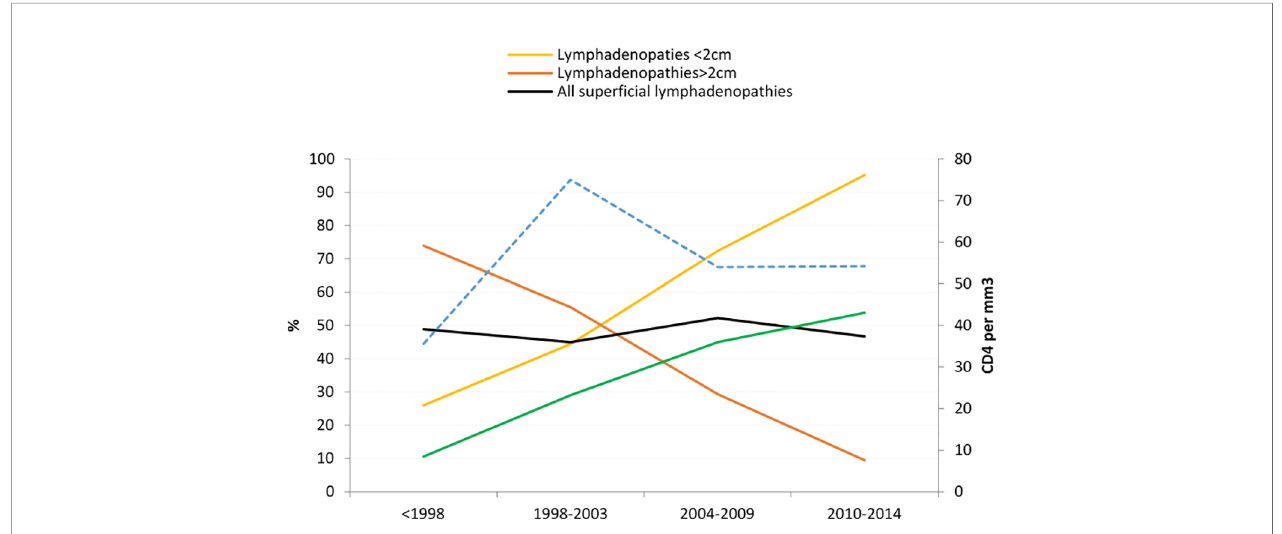
FIGURE 2 | Evolution of the proportion of patients with lymphadenopathies by